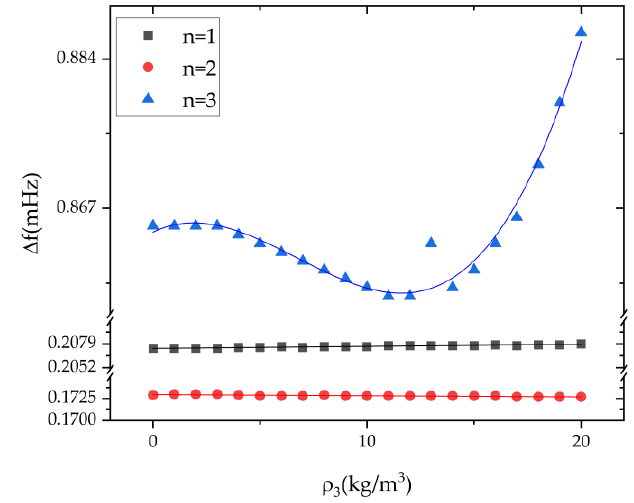
Figure 8. The influence of the third harmonic ρ 3 on the frequency split of n = 1, 2, 3 modes.